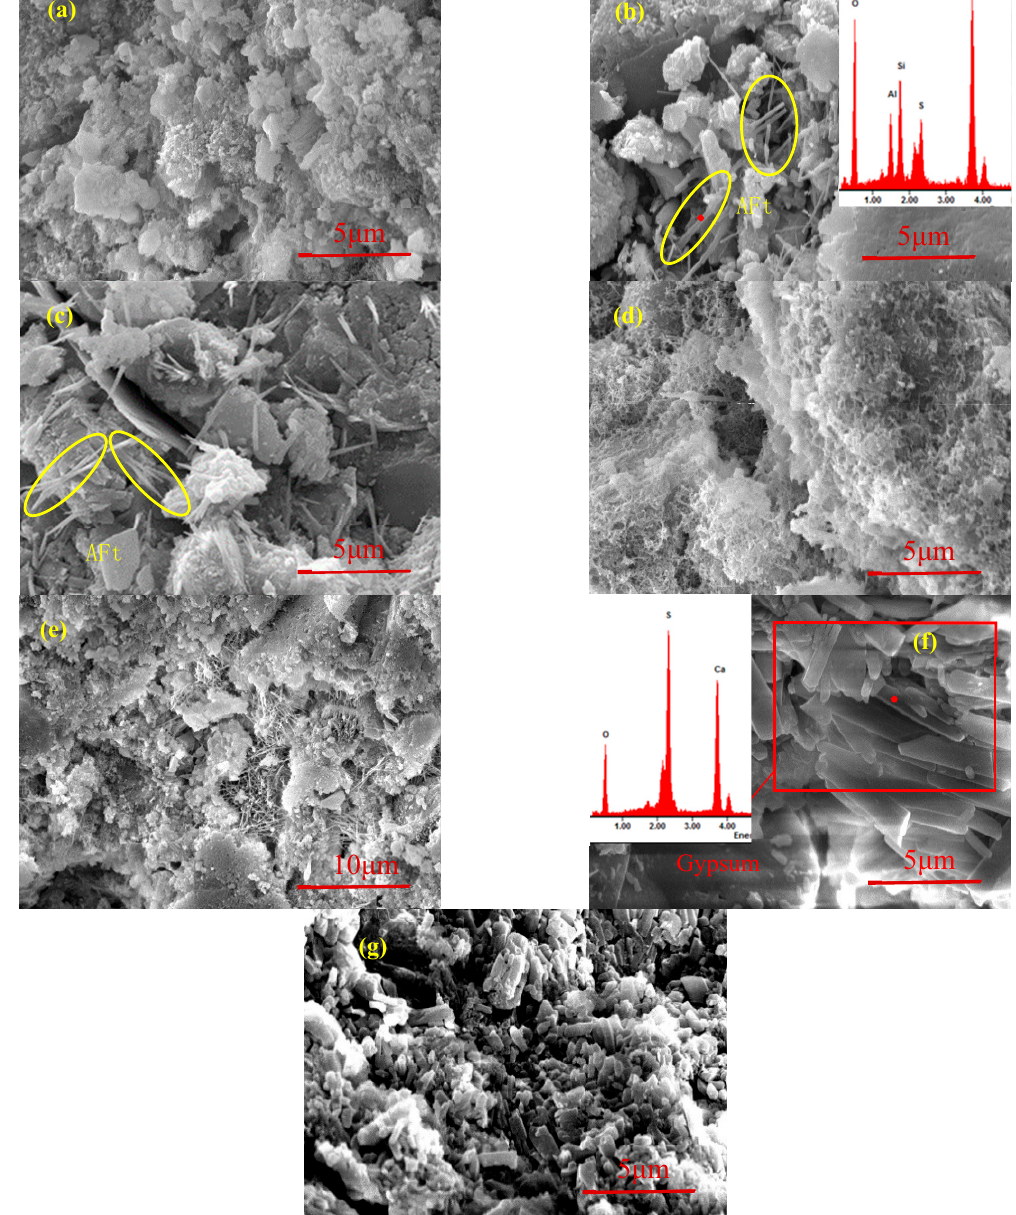
Figure 5. Mineral-phase composition of C30 specimen at different sulfuration ages: ( a ) flocculent hydration products for zero days; ( b ) the formation of AFt for two days; ( c ) the increase of AFt for five days; ( d ) non-gelling silica gels for five days; ( e ) the decomposition of the AFt for 10 days; ( f ) the formation of gypsum for 10 days; and ( g ) a large amount of gypsum for 20 days.